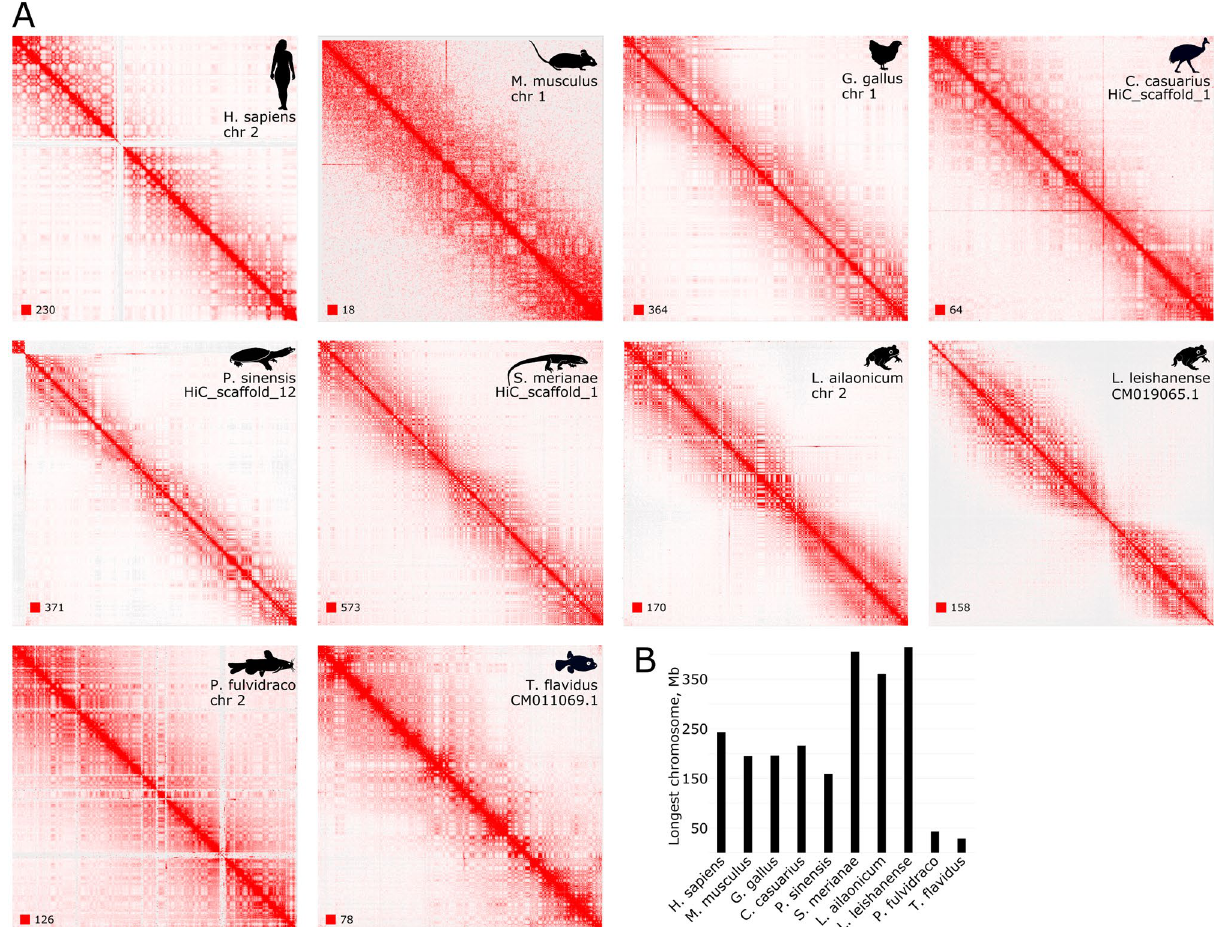
Figure 4. 3D genome organization of erythrocytes in vertebrates. ( A ) Representative Hi-C heatmap of one of the long chromosomes for each species under analysis. ( B ) Chart of chromosome sizes depicted in ( A ). Hi-C maps were visualized with Juicebox (version 1.11.08) 7